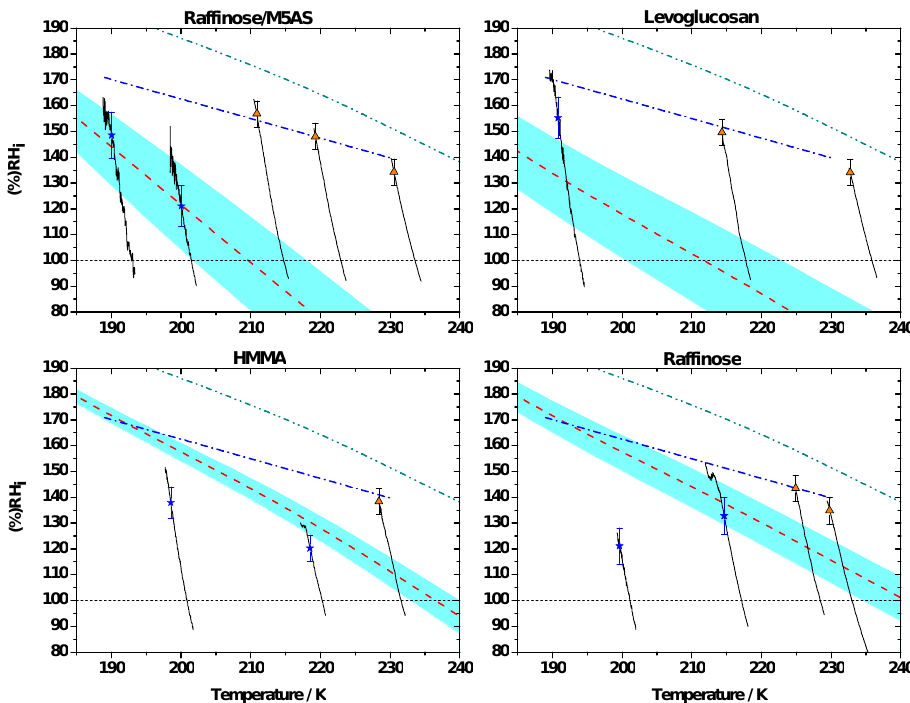
Fig. 7. The experimental temperature – RH i trajectories for the expansion experiments for each aerosol type (solid black lines). Associated with each trajectory is an ice nucleation onset determined using the depolarisation measurement (defined by a change in the depolarisation ra- tio of at least 1% – for example see Fig. 5), with orange triangles representing homogeneous ice nucleation onsets and blue stars representing heterogeneous ice nucleation onsets. The figures also show the aerosol RH g thresholds (dashed red lines) and their associated uncertainties (shaded blue areas) based on parameterisations from Zobrist et al. (2008). The point at which RH g crosses the marked 100% RH i line (dotted black line) is equal to T 0 g for that aerosol type. Also shown is the water saturation line (cyan dot-dot-dash line, shows where RH liq is equal to 100%) and the expected homogeneous freezing threshold (blue dot-dash line), based on the homogeneous freezing of sulphuric acid solution aerosol in the AIDA chamber (M¨ohler et al.,